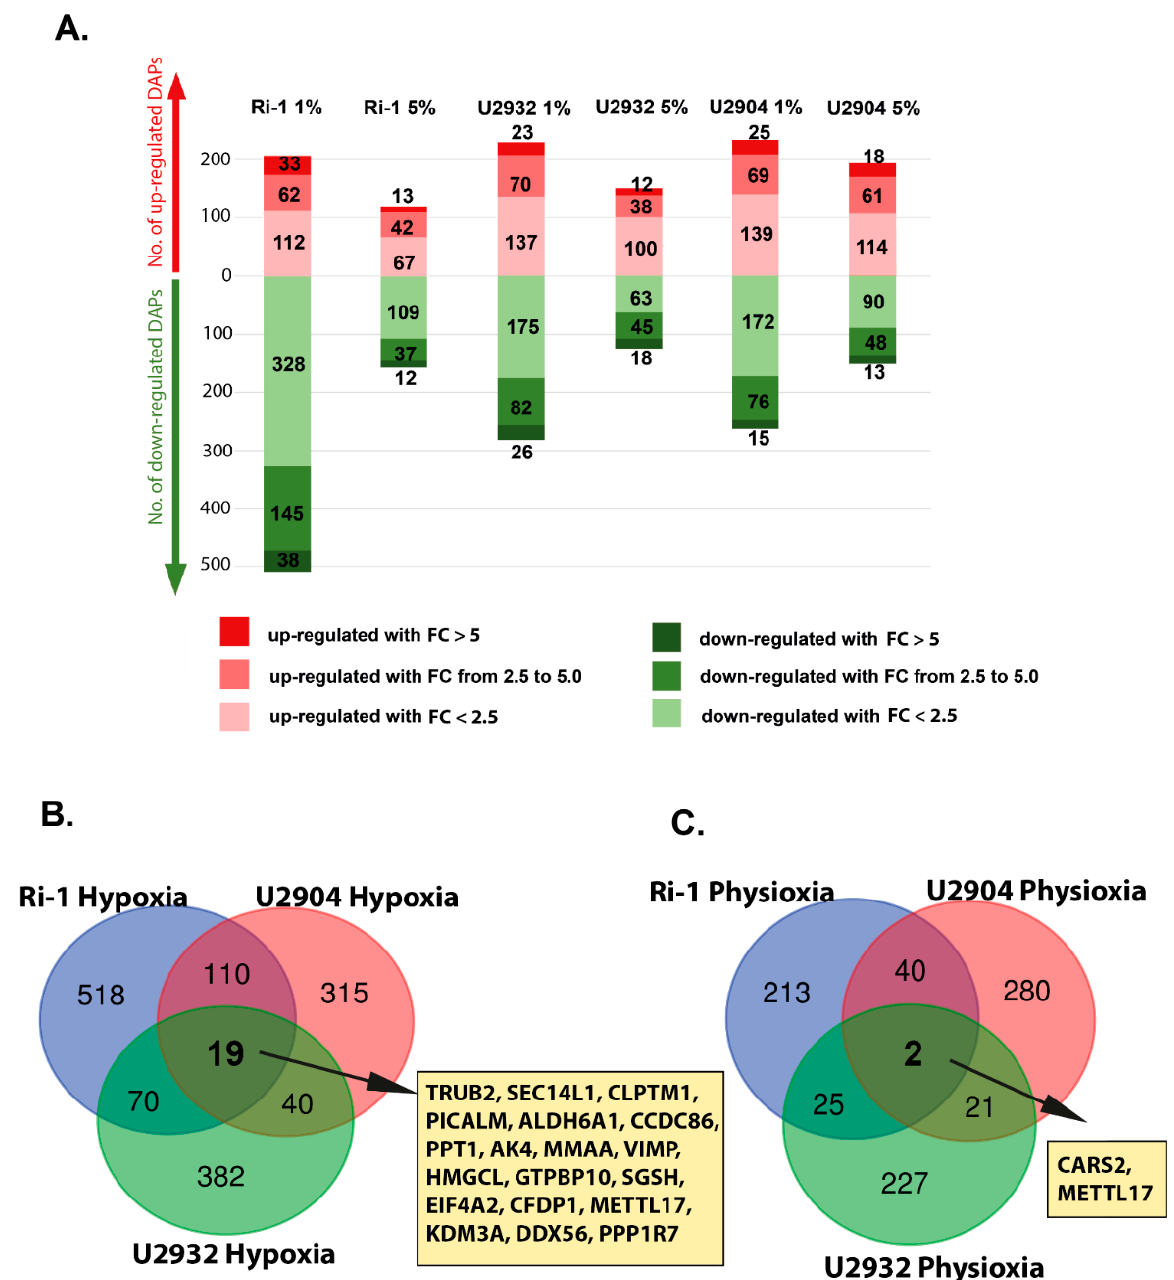
Figure 3. ( A ) Classification of differentially abundant proteins (DAPs) identified in hypoxia (1% of O 2 ) and physioxia (5% O 2 ) based on fold changes in protein abundance in comparison to control samples maintained in standard oxygen condition, p < 0.05. The red and green bars show the number of up- and downregulated proteins, respectively. The color gradation shows increasing fold changes. ( B ) Venn diagrams showing numbers of DAPs overlapping between Ri-1, U2904, and U2932 cell lines in hypoxia (1% of O 2 ), and ( C ) physioxia (5% of O 2 ). The list of shared proteins is provided in Table S3.